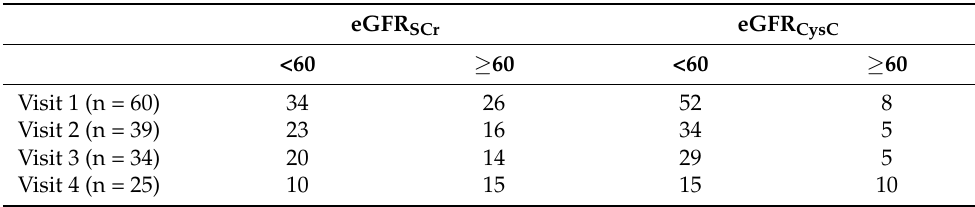
Table 4. Number of patients with eGFR < 60 mL/min/1.73 m 2 and eGFR ≥ 60 mL/min/1.73 m 2 based on SCr and CysC in each follow-up visit.